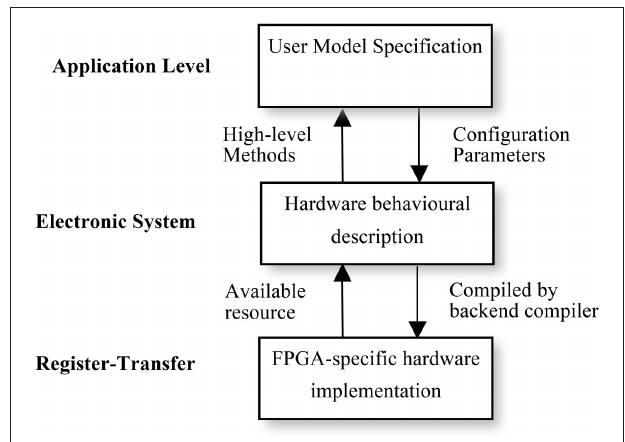
FIGURE 6 | Levels of description for neural simulation in NeuroFlow. The description of the system of NeuroFlow consists of a number of levels: Application level, electronic system level and register-transfer level. Users of the system only codes in the application level and use functions provided from the levels below, without the need to know the hardware details. Changes to the actual implementation of neural models are made at electronic system level which is hardware independent. The register-transfer level is the implementation at the hardware level and is handled by software provided by the vendor, thus reducing the maintenance effort for the system.